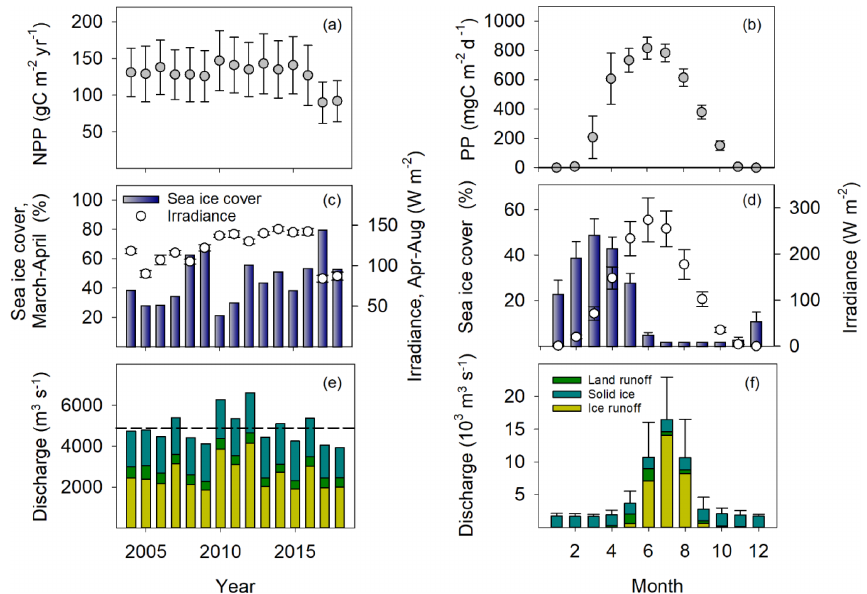
Figure 3. Primary production, sea ice cover, and freshwater discharge in Disko Bay from 2004–2018. Primary production and sea ice cover are assessed in the red square in Fig. 1, whereas the freshwater discharge is from the full model domain. (a) Average annual primary production (gCm − 2 yr − 1 ) ± SD (variation between model grid cells). (b) The average monthly primary production (mgCm − 2 d − 1 ) ± SD (variation between years) – light is averaged from the Arctic station (2010–2019). (c) The annual average sea ice cover in March and April (%). (d) The average monthly sea ice cover (%). (e) The average annual freshwater discharge (m 3 s − 1 ). (f) The average monthly freshwater discharge (1000m 3 s − 1 ). Table 3. Statistics for the spatial comparison between remote sensing data and surface model data for spring (April–June) and summer (July–September) in 2010 and 2017. In spring 2017, only June is included due to ice cover in April–May. N = 6145, and all correlations were significant ( p< 0 . 01). Model error RMSE Correlation cf Surface temperature 2010 spring